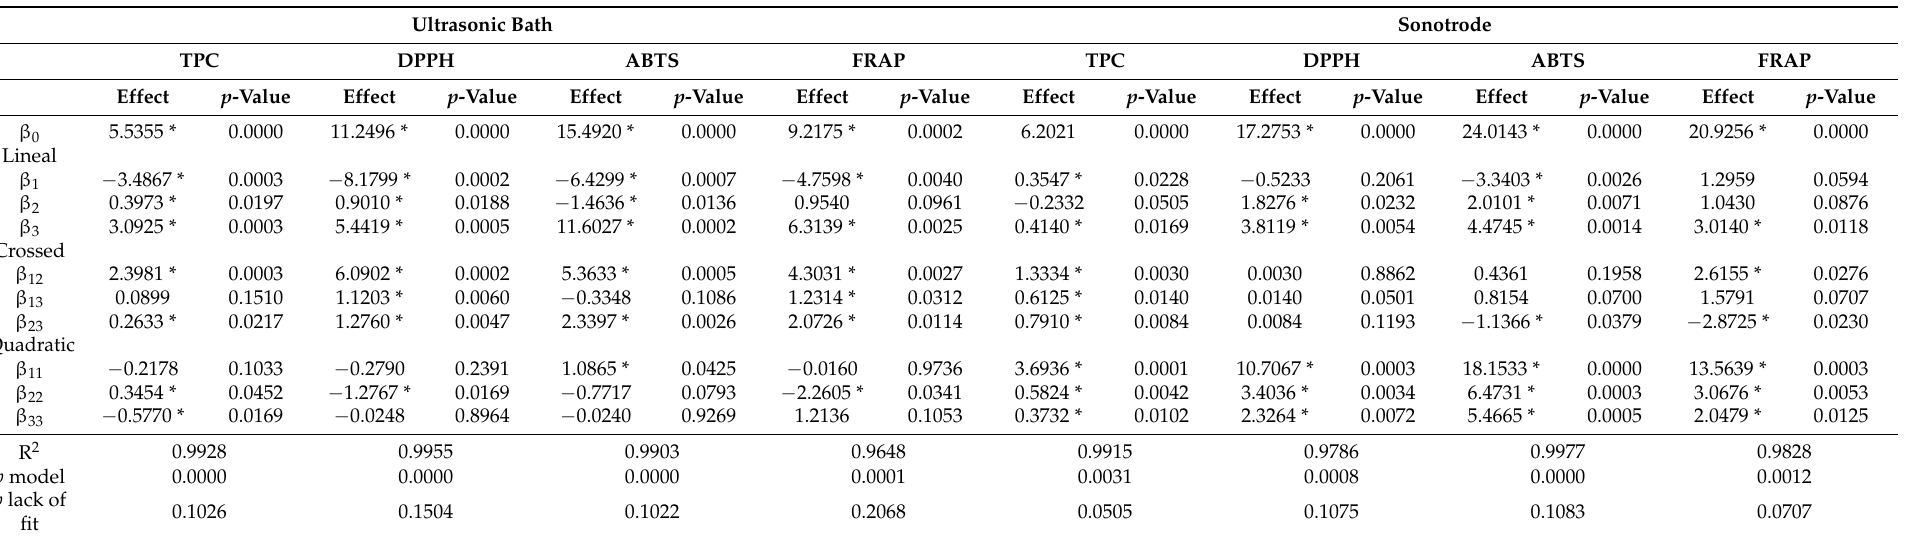
Table 2. Estimated regression coefficients of the adjusted second-order polynomial equation and analysis of variance (ANOVA) of the sonotrode and ultrasonic bath